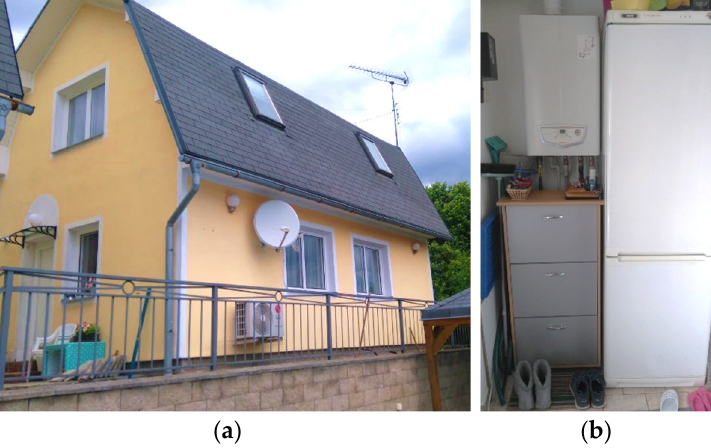
Figure 3. The single-family house considered for the test previous to the intervention, located at Jablonec nad Nisou (50.7N, 15.1W coordinates): ( a ) Outdoor view of the building south rooftop and façade; ( b ) Indoor room with existing boiler and further household appliances.